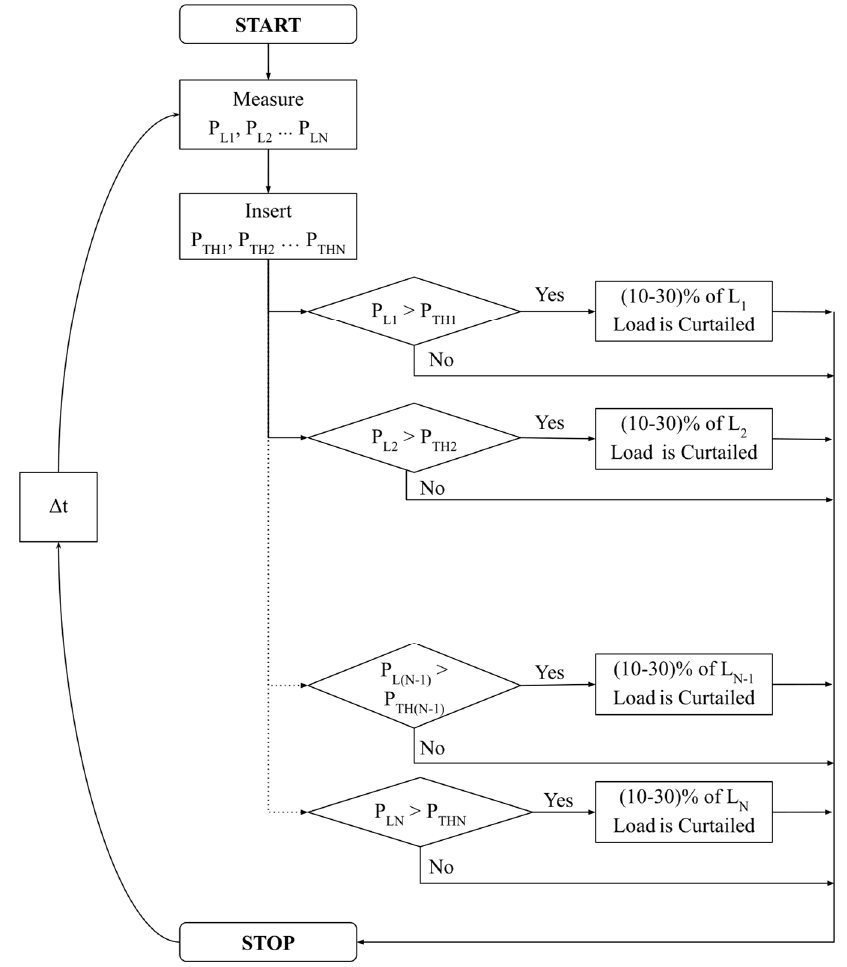
Figure 3. DLC algorithm flowchart.